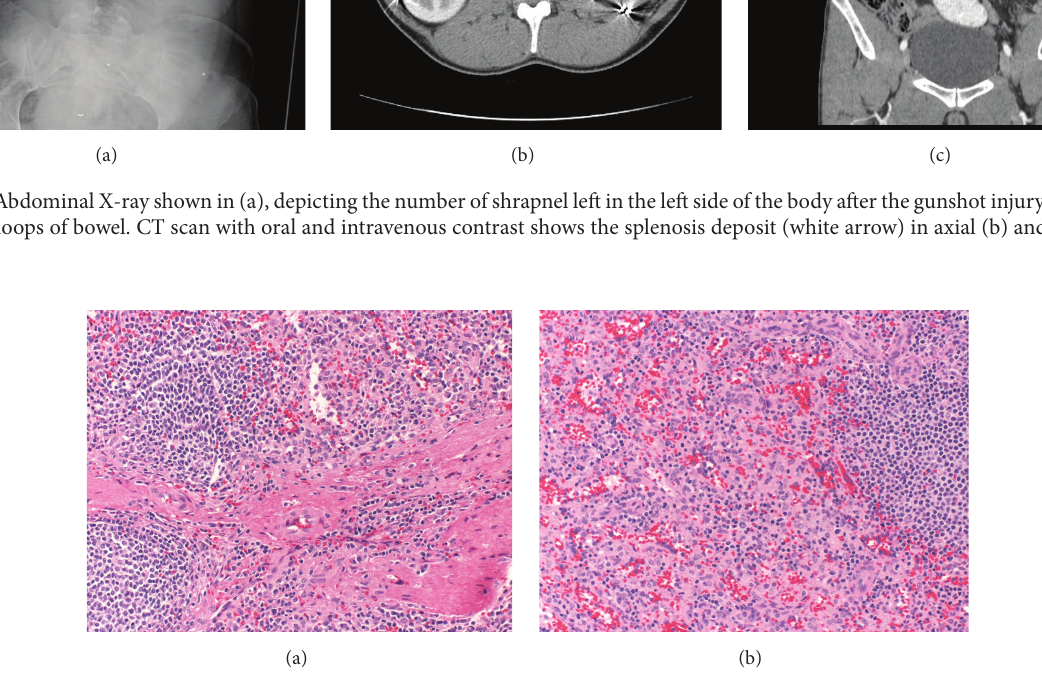
Figure 2: H&E stained slides of the splenosis deposit showing splenosis architecture. Splenic nodules separated by strands of fibrous trabeculae (a). White and red pulp nodules are seen